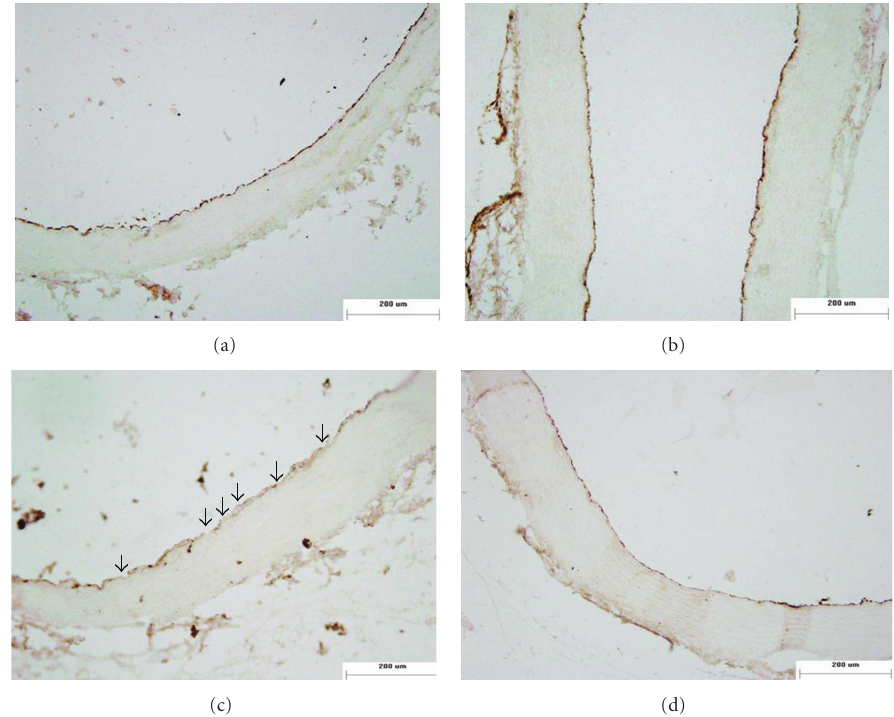
Figure 4: E ff ect of genistein on thoracic aortas morphological changes measured by immunohistochemical staining of vWF ( × 100). (a) Con; (b) Met; (c) OVX + Met; (d) OVX + Met + GST. The continuity of vWF positive staining (indicating endothelium) was interrupted in OVX + Met group, with negative staining in some parts of the inner wall (showed by ↑ ), while genistein could markedly improve the continuity of vWF positive staining of OVX + Met